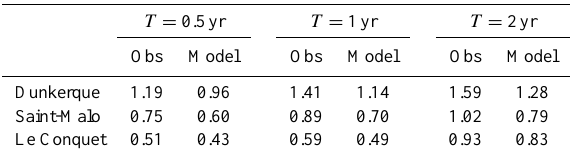
period 2003–2009.